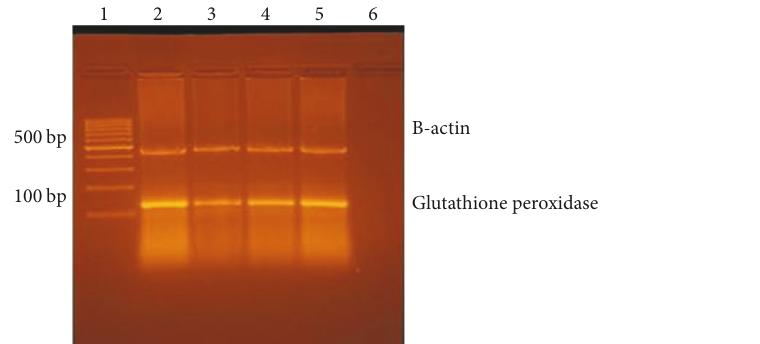
Figure 15: Agarose gel electrophoresis of RT-PCR products showed increase in the expression of GSH-Px genes in adrenal glands in tramadol withdrawal groups (groups III and IV) more than tramadol group (group II).